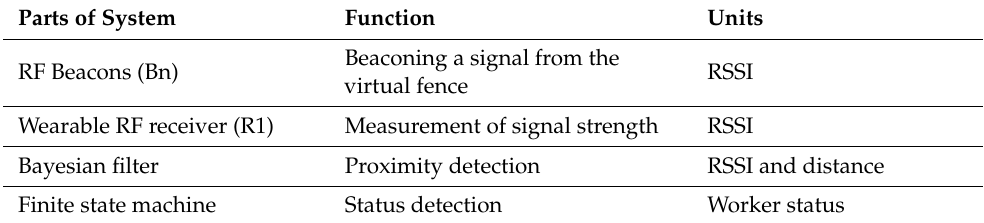
Table 2. Virtual fence system